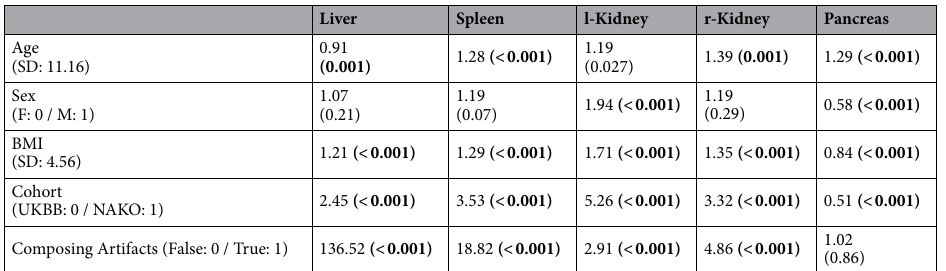
Table 2. Association of epidemiological/imaging factors with segmentation errors (odds ratio ( p values), statistically significant p values are in bold).